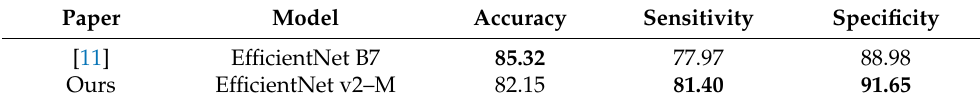
Table 13. Performance comparison on multi-class classification on the NIH data set